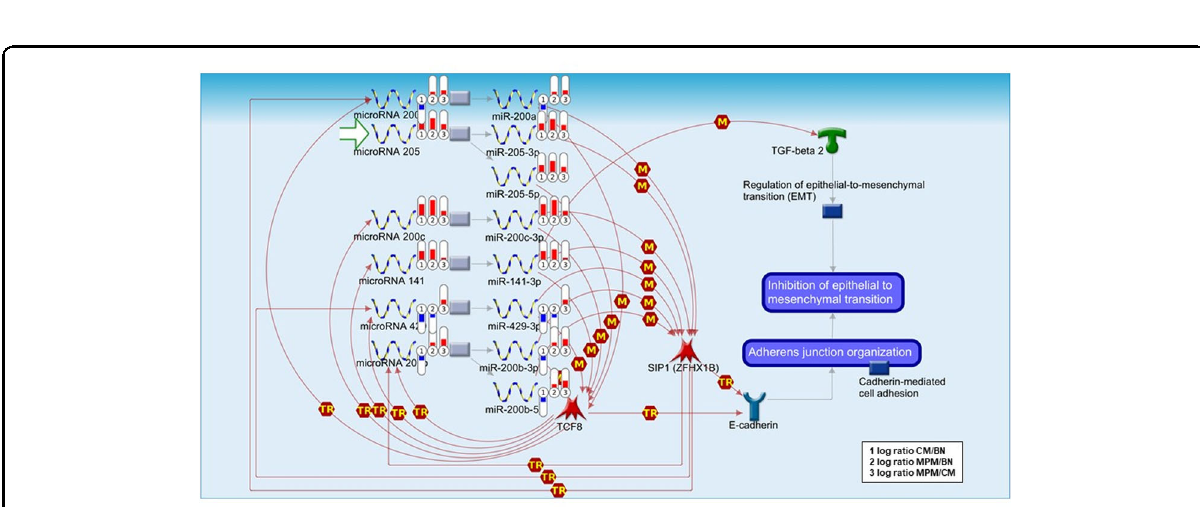
Fig. 4 MetaCore pathway analysis showing the involvement of differently expressed miRNAs in epithelial – mesenchymal transition (EMT). EMT pathway representation with regulating miRNAs. Log ratio of miRNA expression level in CM/BN (1), MPM/BN (2), and MPM/CM (3) is visualized on the maps as a thermometer-like fi gure. Upward thermometers have a red color and indicate upregulated signals, and downward (blue) ones indicate downregulated expression level of speci fi c microRNAs. “ M ” indicates microRNA binding (regulation of gene expression by binding of microRNA to target mRNA), whereas “ TR ” indicates Transcription regulation (physical binding of a transcription factor to target gene ’ s promoter). MPM showed higher expression levels of microRNAs involved in the inhibition of epithelial – mesenchymal transition (EMT), including miR-205-5p and miR-200b-3p. (BN, benign nevi; CM, cutaneous melanoma; MPM multiple primary